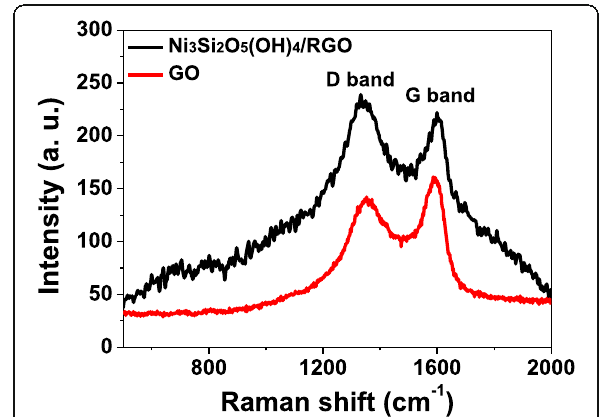
Fig. 4 Raman spectra of Ni 3 Si 2 O 5 (OH) 4 /RGO hollow microspheres ( black curve ) and GO sheets ( red curve ), showing the D and G